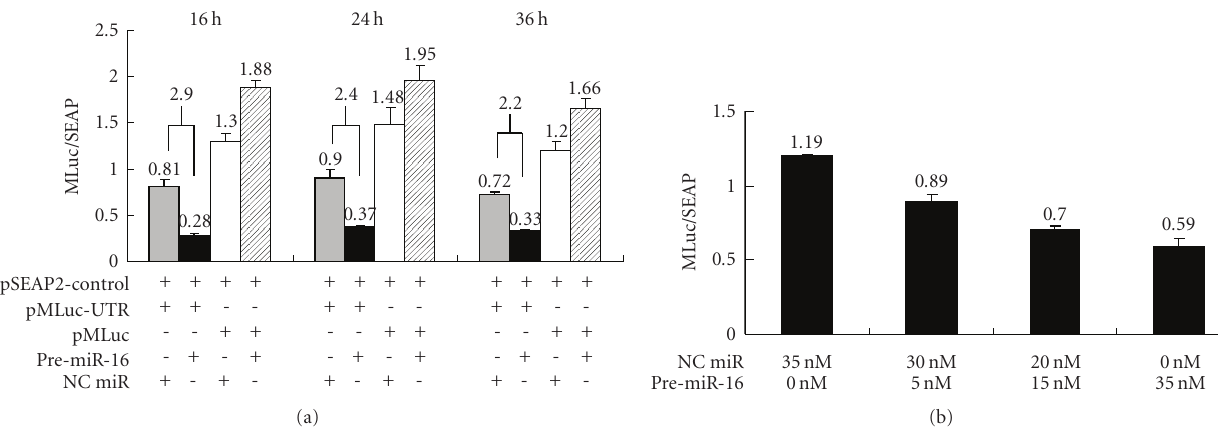
Figure 2: Reporting ability of the multisampling reporter system. HEK293T cells were grown in 6-well plates to 70% confluency. (a) The cells were cotransfected with 0.5 μ g of pSEAP2-Control, 0.5 μ g of pMLuc or pMLuc-UTR, and 30nM pre-miR-16 or NC miR. The medium was replaced with fresh medium at di ff erent time points after transfection, and an aliquot of medium was withdrawn 2 hours later and assayed for MLuc and SEAP. (b) The cells were cotransfected with 0.5 μ g of pMLuc-UTR and pSEAP2-Control, together with di ff erent concentration of pre-miR-16 (0–35nM) and NC miR (35–0 nM), then, 24 hours later, an aliquot of medium was withdrawn from each culture medium and assayed. The data presented are the mea n ± SD of triplicates.